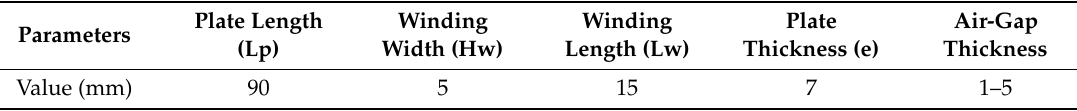
Table 1. Geometrical parameters of the actuators.